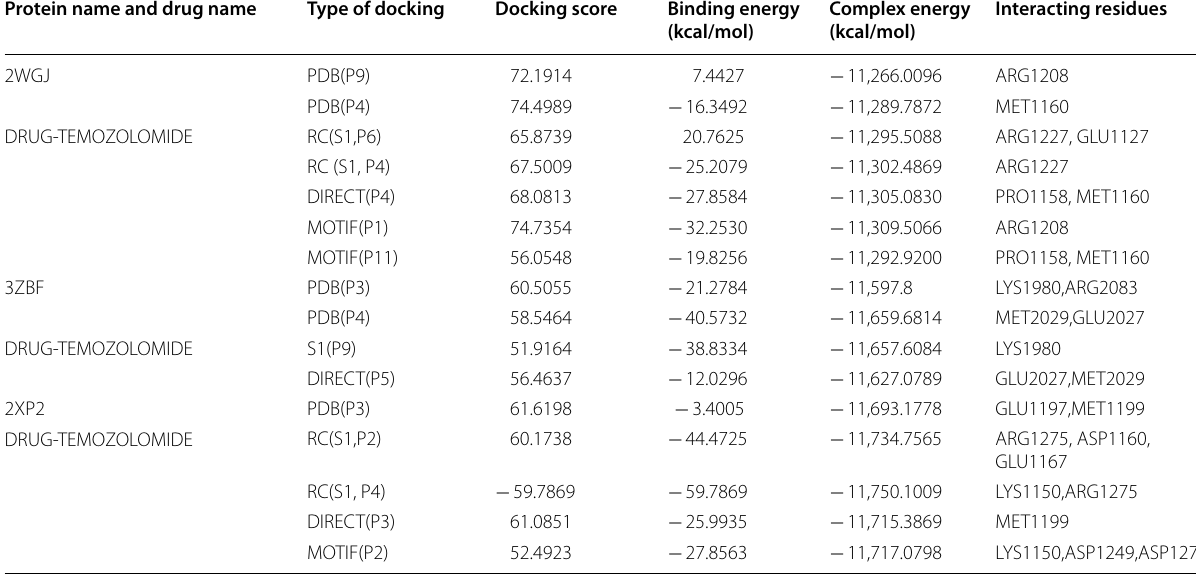
Table 7 Docking results of a best-docked complex of Temozolomide drug with C-MET, C-ROS1 and ALK proteins Protein name and drug